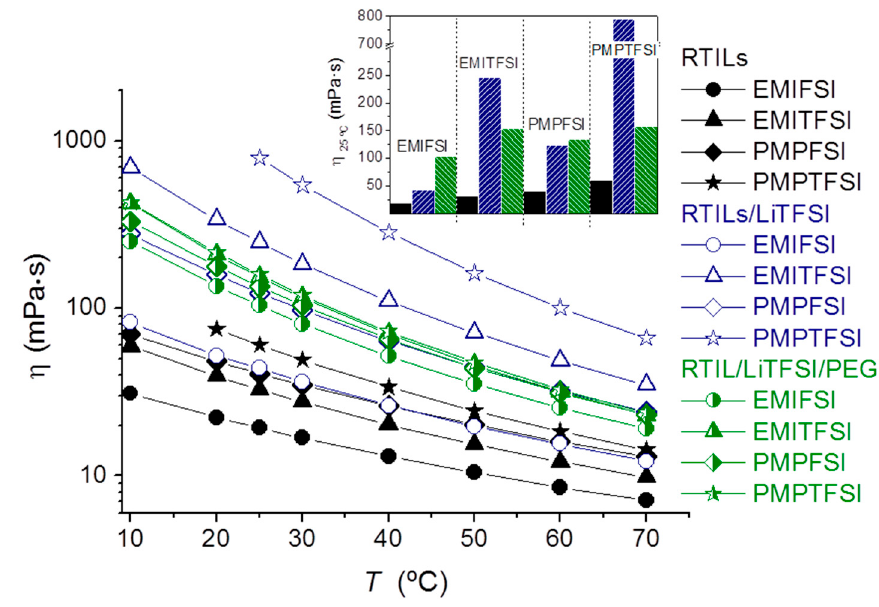
Figure 1. η dependence on temperature for RTILs (black) and solutions with LiTFSI (blue) and LiTFSI + PEG (green). The inset shows the viscosity at 25 °C divided into groups attending to the RTIL nature (color code as before).